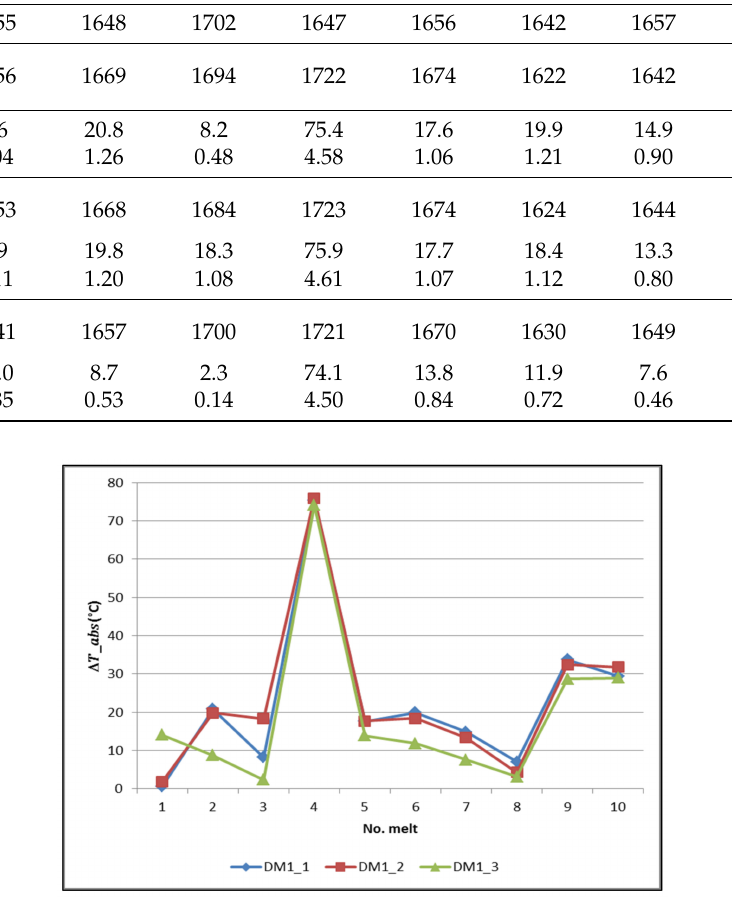
Figure 7. Absolute deviation of temperature for deterministic model with